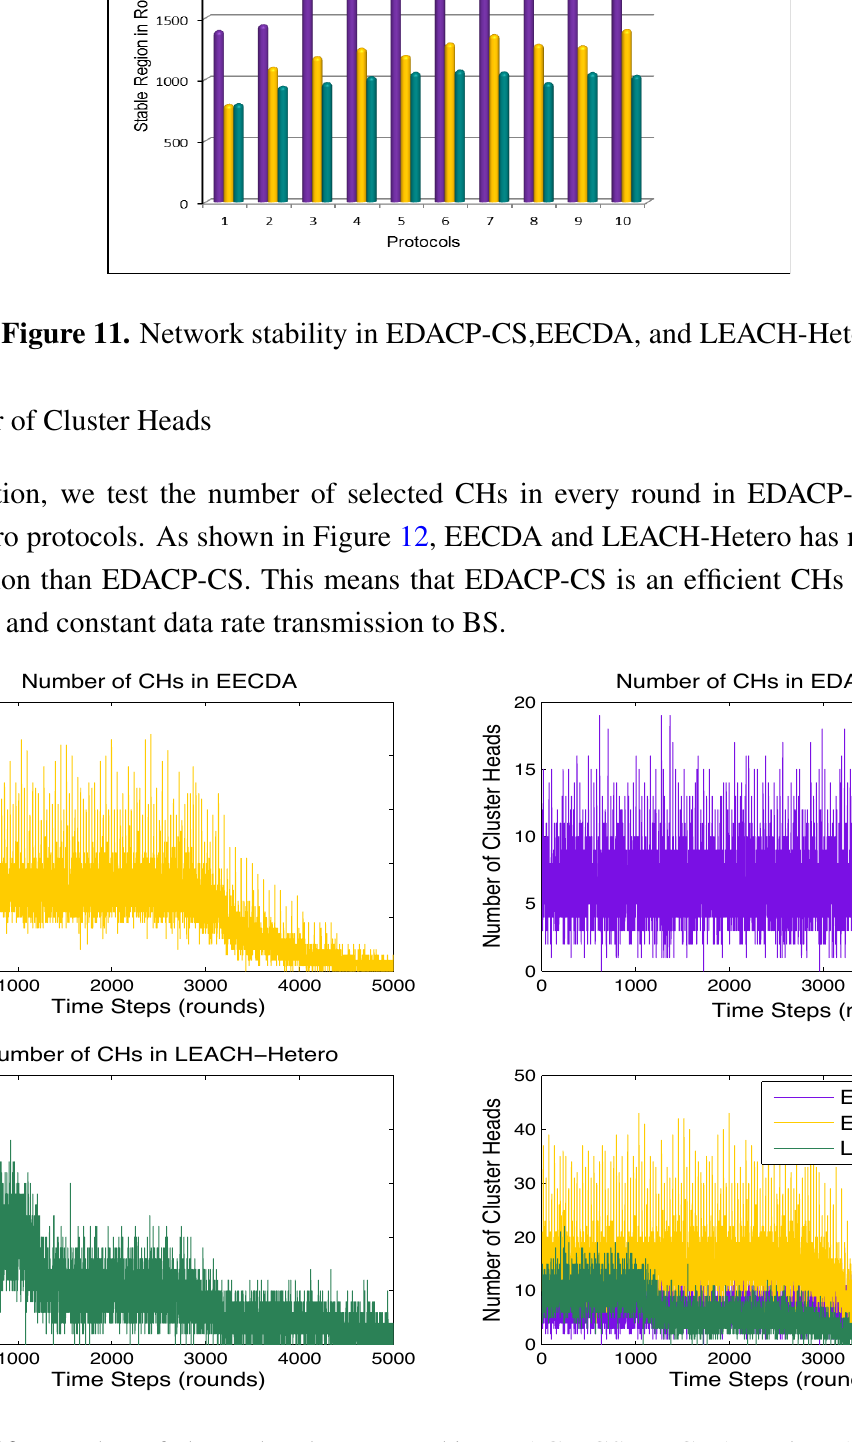
Figure 12. Number of cluster heads per round in EDACP-CS, EECDA, and